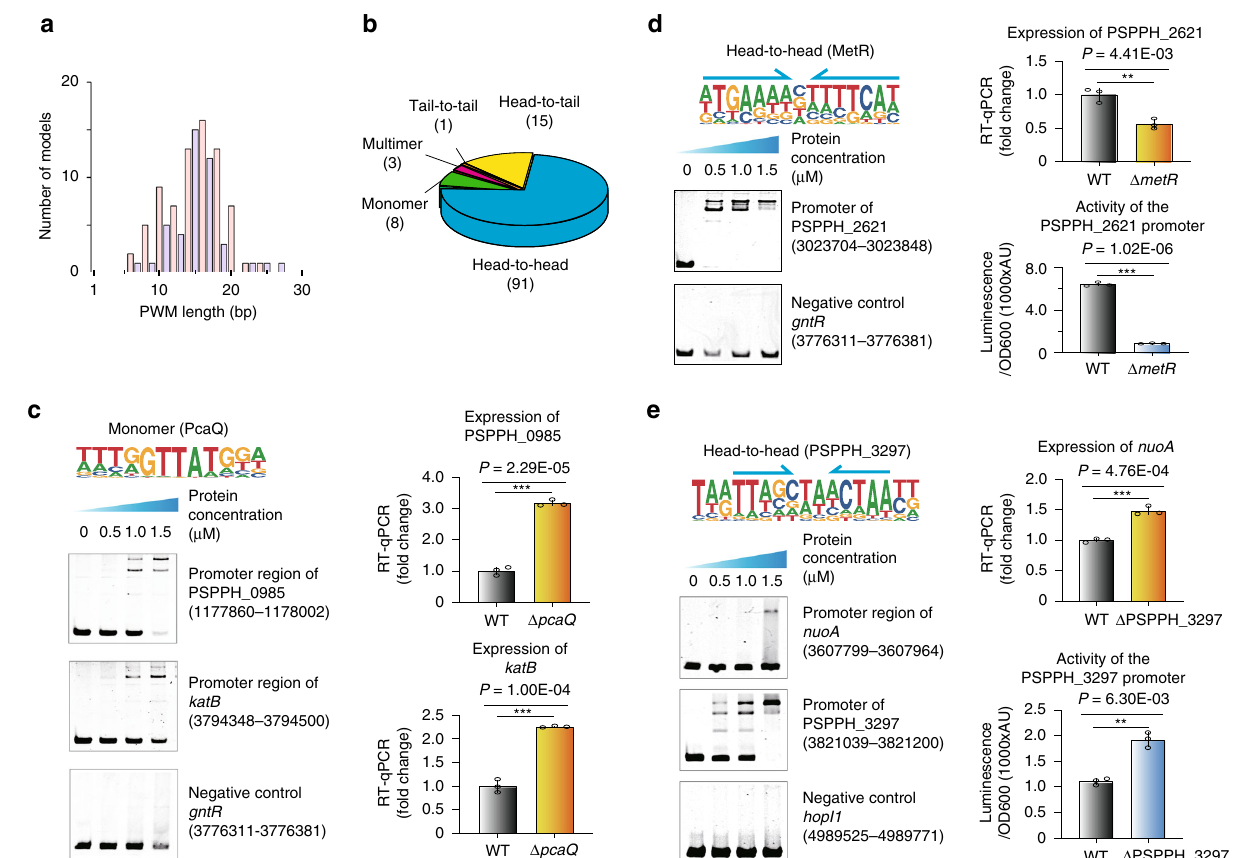
Fig. 2 Validation of different TF-binding modes. a Histogram shows the distribution of PWM model lengths. Note that TFs prefer even (red) over odd (blue) lengths due to more dimeric motifs, and that the speci fi city of most PWM length shows ~15 bp. b Pie chart shows the category of different TF- binding modes. Classi fi cation of all binding models into non-repetitive sites (monomer), and sites with two or three similar subsequences (dimer and multimer, respectively). The dimeric types are further classi fi ed as head-to-head, head-to-tail, and tail-to-tail. c Validation of the binding of PcaQ by EMSA and RT-qPCR. The putative binding sites from the promoter of target gene PSPPH_0985 and katB were veri fi ed using EMSA, respectively, and a fragment taken from the gntR promoter was used as the negative control. The expression of target gene PSPPH_0985 and katB was measured in wild-type and pcaQ mutant ( Δ pcaQ ) by RT-qPCR, respectively. Logo shows the binding site model of PcaQ. d Validation of the binding of MetR by EMSA, RT-qPCR, and a reporter assay. The binding site from the promoter of target gene PSPPH_2621 was veri fi ed using the EMSA, and a fragment taken from the gntR promoter was used as the negative control. The expression of target gene PSPPH_2621 was measured in wild-type and metR mutant ( Δ metR ) by RT-qPCR. The promoter activity of target gene PSPPH_2621 was evaluated in wild-type and metR mutant by the reporter assay. Logo shows the binding site model of MetR, with its monomeric half-sites indicated with arrows. P value is 4.410E-03 (upper). P value is 1.017E-06 (lower). e Validation of the binding site of PSPPH_3297 by EMSA, RT-qPCR, and a reporter assay. The putative binding sites from the promoter of target gene nuoA and PSPPH_3297 were veri fi ed using the EMSA, respectively, and a fragment taken from the hopl1 promoter was used as the negative control. The expression of target gene nuoA was measured in wild-type and PSPPH_3297 mutant ( Δ PSPPH_3297) by RT-qPCR. The promoter activity of target gene PSPPH_3297 was evaluated in wild- type and PSPPH_3297 mutant by a reporter assay. Logo shows the binding site model of PSPPH_3297, with its monomeric half-sites indicated with arrows. P value is 4.760E-04 (upper). P value is 6.300E-03 (lower). Statistic P values by two-tailed Student ’ s t test are shown; *P < 0.05, *** P < 0.001 ( c – e ). Three independent biological replicates were performed ( c – e ). Error bars show standard deviations. TF transcription factor, PWM position weight matrix. Also see Supplementary Figs. 2, 3, and Supplementary Data